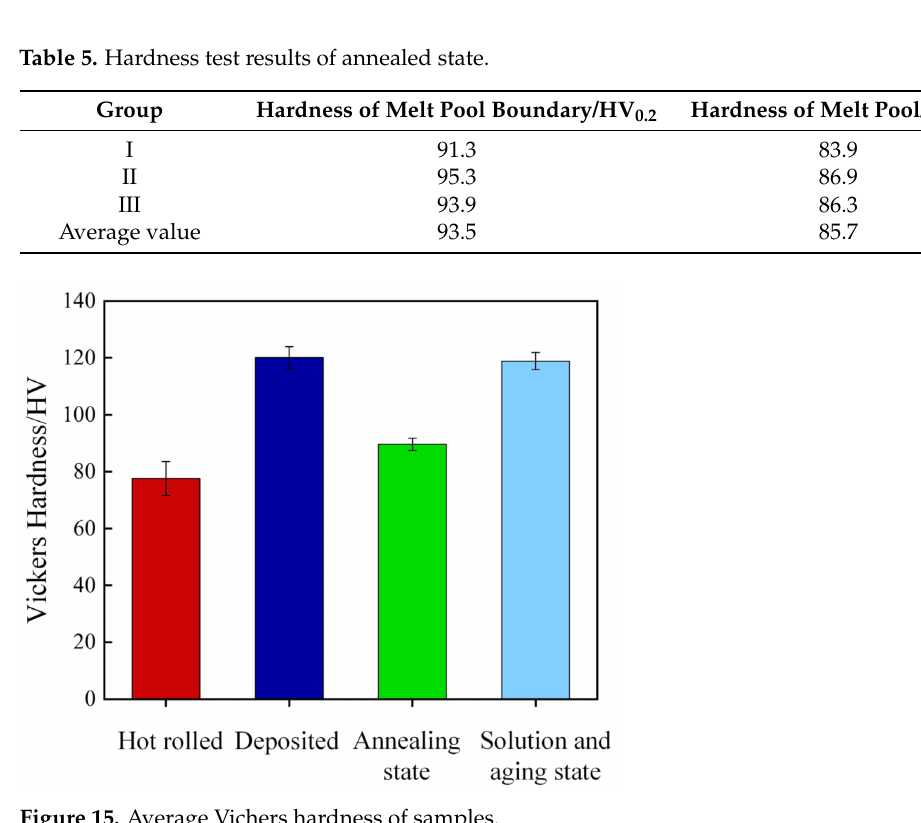
Figure 15. Average Vichers hardness of